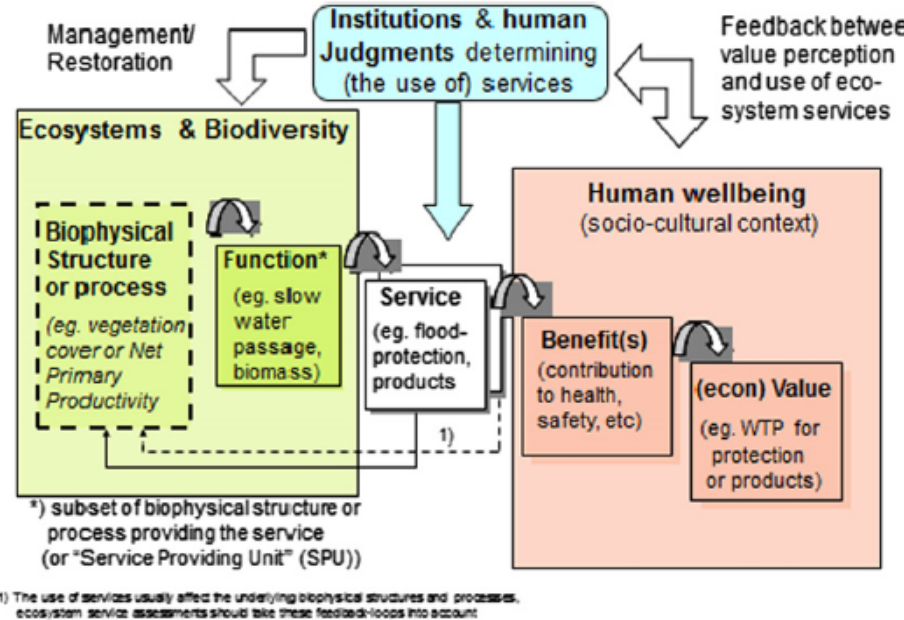
Figure 2. The Economics of Ecosystems and Biodiversity Framework. WTP, willingness to pay. Reproduced from Braat and de Groot 78 (2012), adapted from Haines-Young and Potschin 25 (2010).